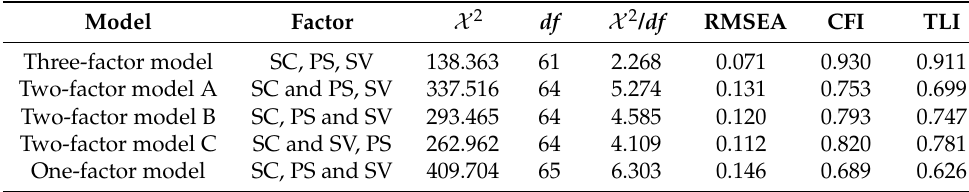
Table 2. Results of confirmatory factor analysis (N =